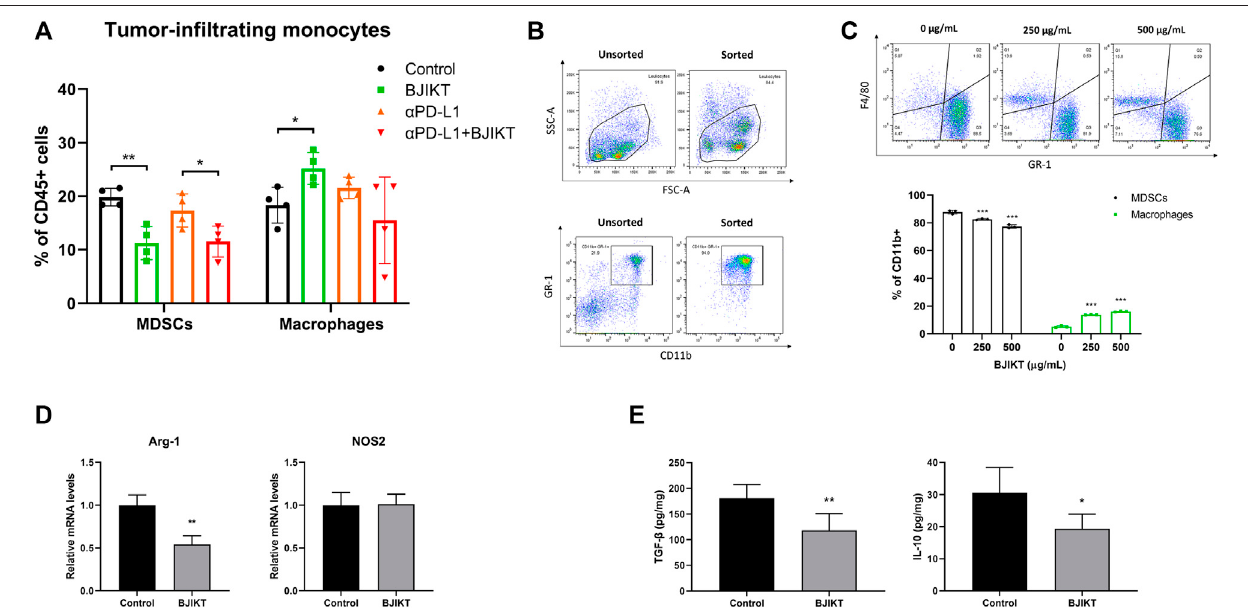
FIGURE 6 | BJIKT regulated antitumor immunity by attenuating MDSCs and promoting antitumor cytokines in the tumor microenvironment. (A) The subsets of tumor-in fi ltrating monocytes, including MDSCs(CD11b + GR-1 + )and macrophages(CD11b + F4/80 + )intumor tissues wascon fi rmedusing fl owcytometry. * p < 0.05and ** p < 0.01,comparedbetweeneachgroup. (B) ThepurityofMDSCs.MDSCswerepuri fi edfromsplenocytesisolatedfromthespleenofMC38tumor-bearingmice.The sortedMDSCswerecon fi rmedusing fl owcytometry. (C) TheeffectofBJIKTonMDSCdifferentiation invitro .MDSCsweretreatedwithBJIKTfor36 h.Thesubsets ofMDSCsandmacrophageswereanalyzedby fl owcytometry. (D) EffectofBJIKTonthemRNAexpressionofnitricoxidesynthase2(NOS2)andarginase1(ARG-1)by quantitative PCR. (E) Effect of BJIKT on levels of antitumor in fl ammatory cytokines, such as interleukin 10 (IL-10) and master regulator transforming growth factor β 1 (TGF- β 1) in tumor tissue. * p < 0.05, ** p < 0.01, and *** p < 0.001, compared to the control